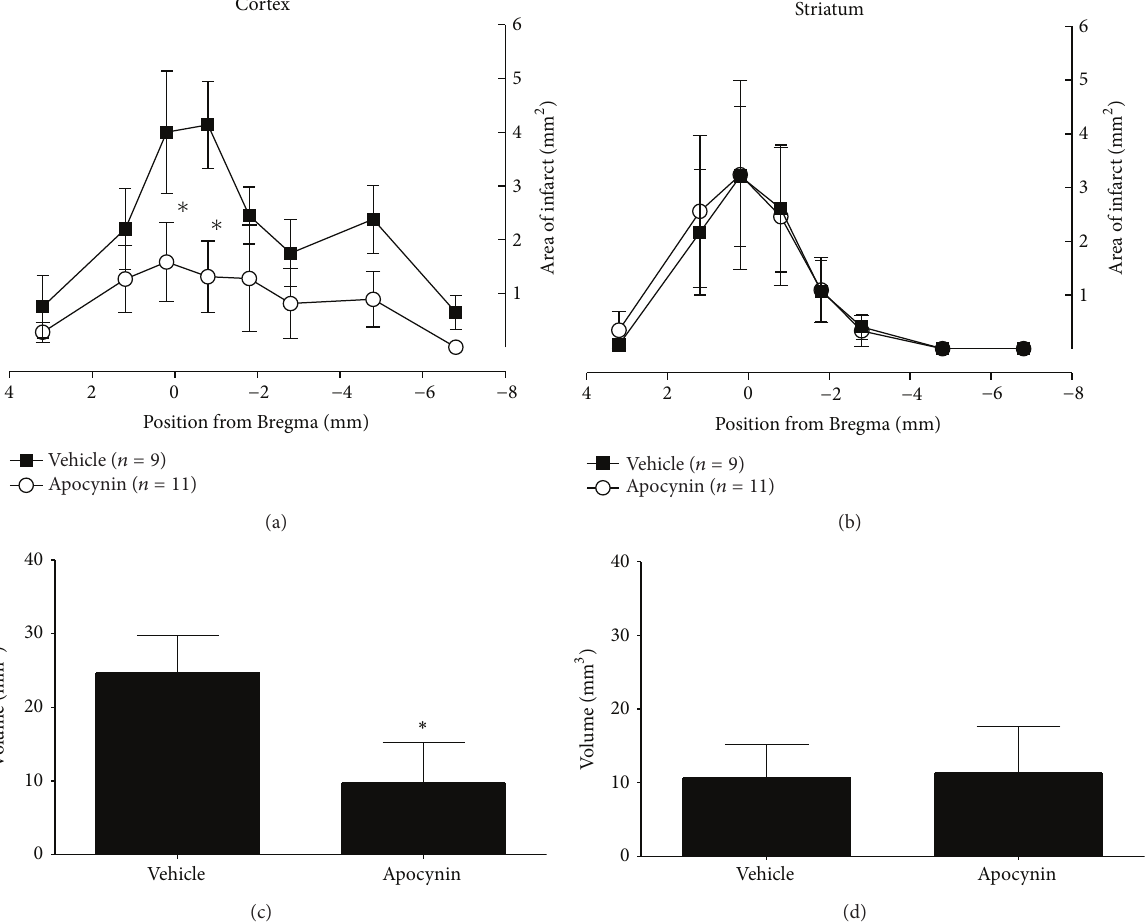
F 2: Effect of apocynin treatment on infarct area in cortex (a) and striatum (b) and total infarct volume in the cortex (c) and striatum (d) following stroke. �oth infarct area and total volume were signi�cantly reduced in the cortex following apocynin treatment, with no effect on the striatum. Data are presented as mean